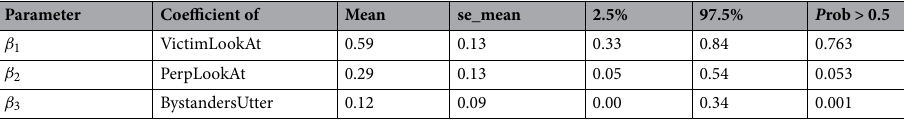
Table 5. Summaries of the posterior distributions of the parameters, showing their mean, standard deviations, and 95% credible intervals. Prob > 0.5 is the posterior probability of the parameter being > 0.5.